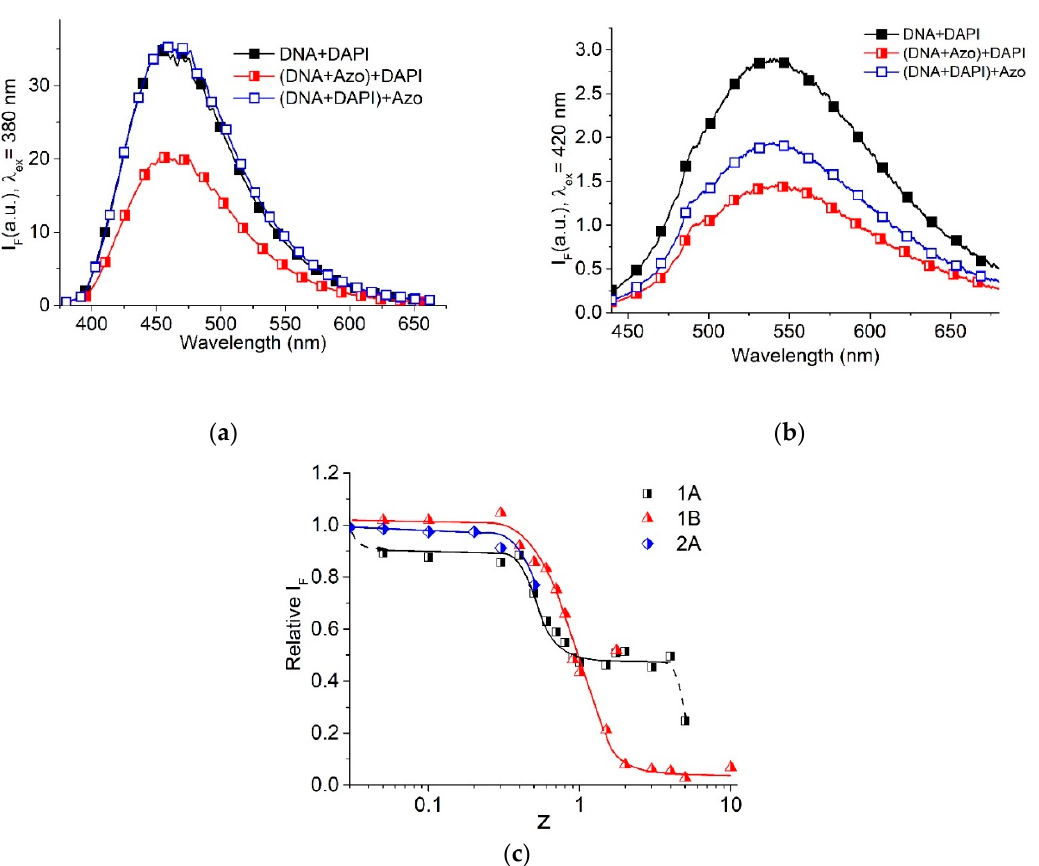
Figure 8. DAPI fluorescence in complexes with DNA before (filled signs) and after (open signs) the addition of surfactant, and after the addition of DAPI to DNA-surfactant complexes (half-filled signs) at r = 0.01 (groove binding), z = 0.3, [DNA] = 4.5 × 10 − 5 M (P), λ ex = 380 nm ( a ); at r = 0.3, z = 0.8, [DNA] = 1.5 × 10 − 5 M (P), λ ex = 420 nm ( b ); dependence of relative intensity of DAPI luminescence on z at 0.005 M NaCl ( c ) at r = 0.3 (1) and 0.03 (2) for λ ex = 380 nm (A) and 420 nm (B), [DNA] = 1.5 × 10 − 5 M (P).